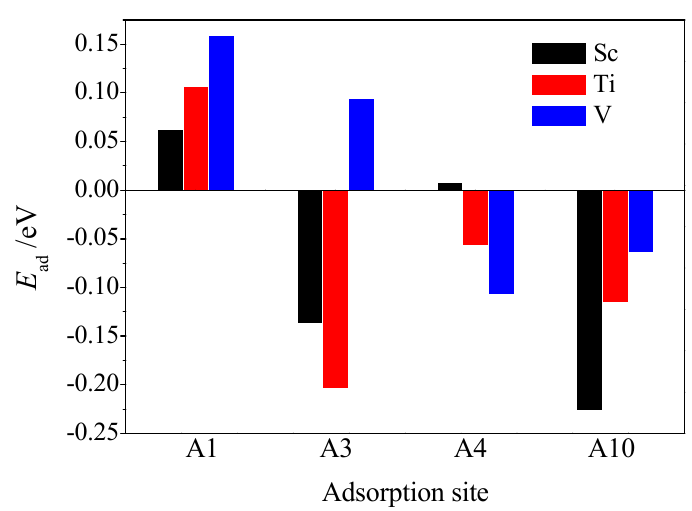
th H 2 molecule for Sc, Ti and V doped